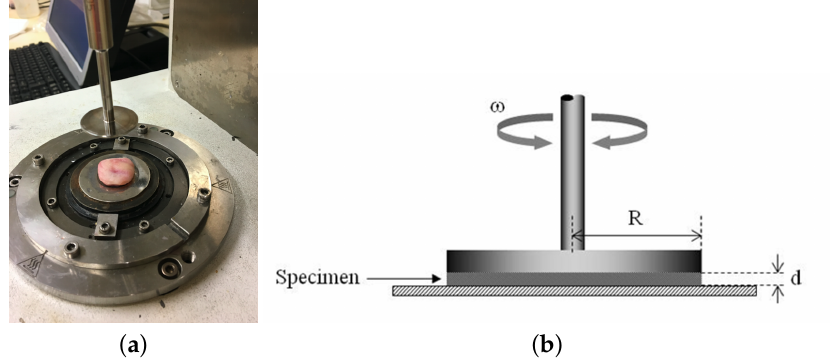
Figure 6. ( a ) A controlled-rate magnetorheometer MCR 300 Physica-Anton Paar, Graz, Austria. Pink matter corresponds to the cervical tissue sample. ( b ) schematic view of the